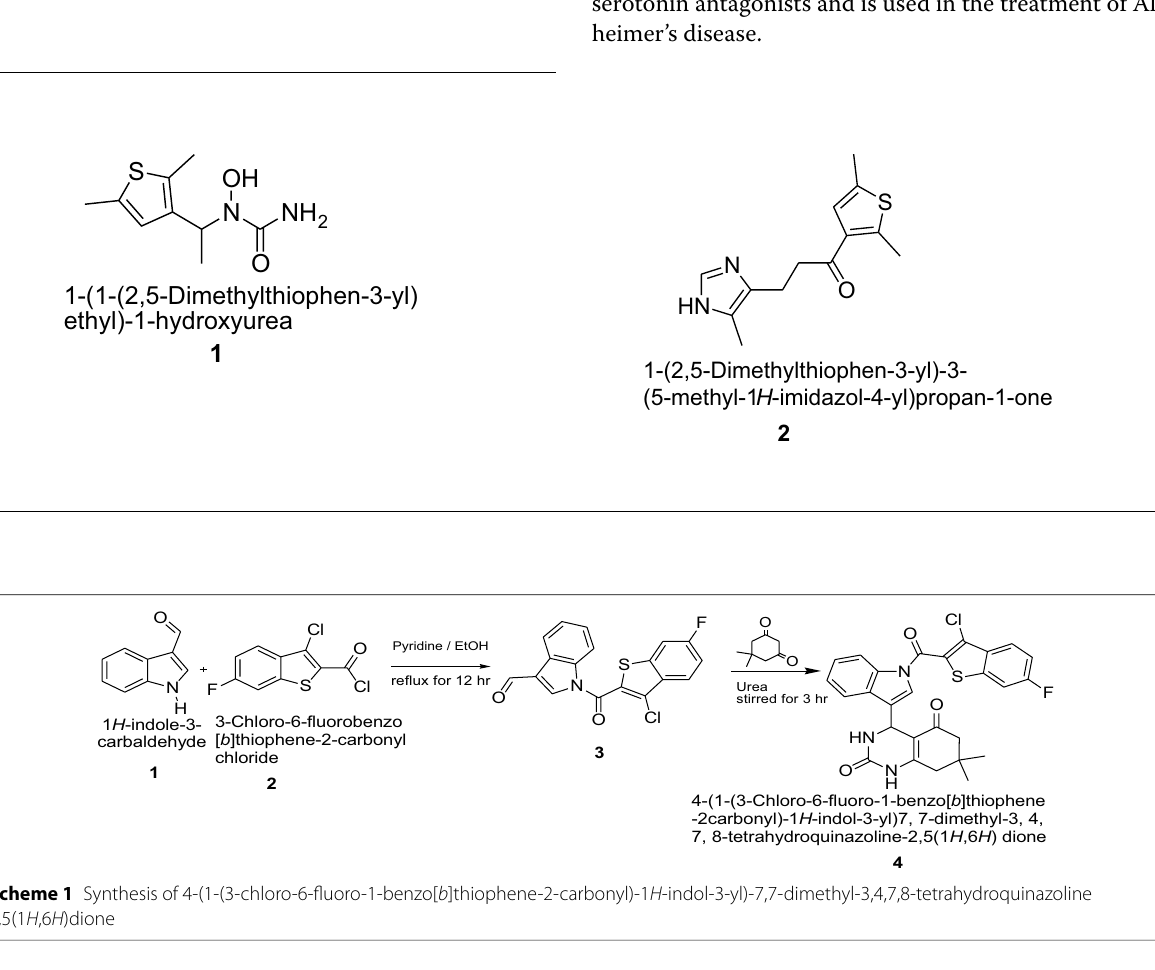
Table 1 Biological activity of synthesized compounds S.